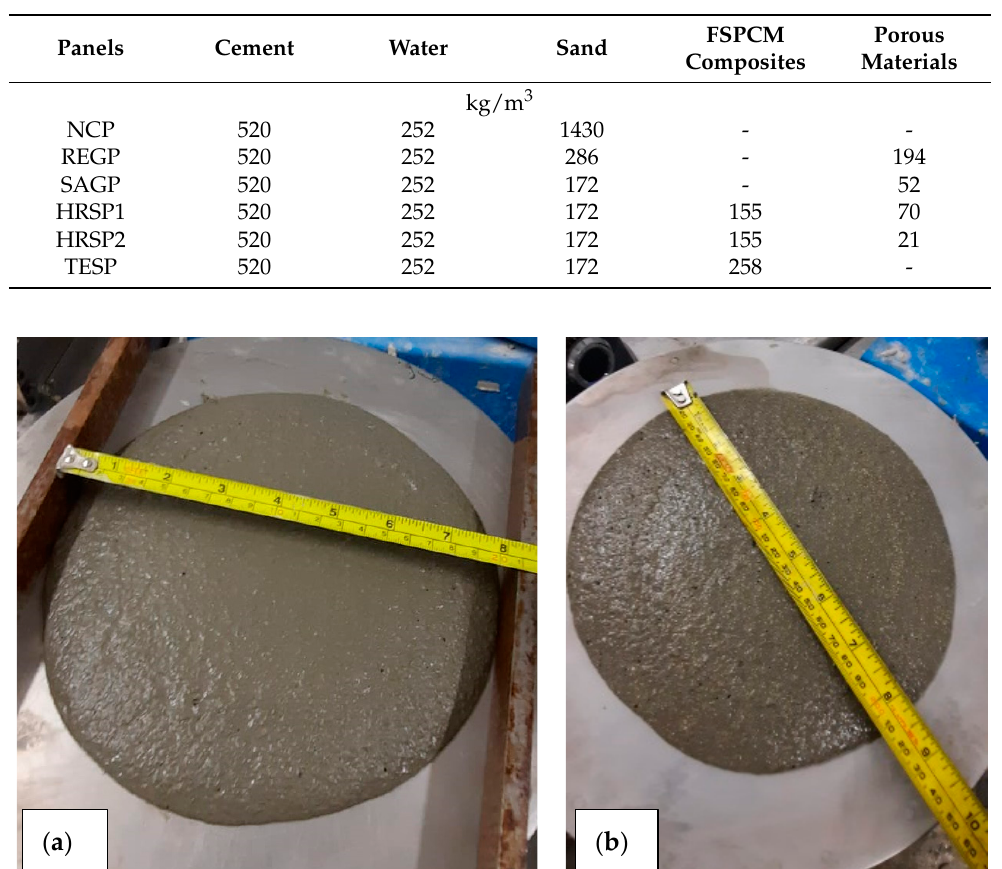
Table 1. Mix design recipe of developed panels.